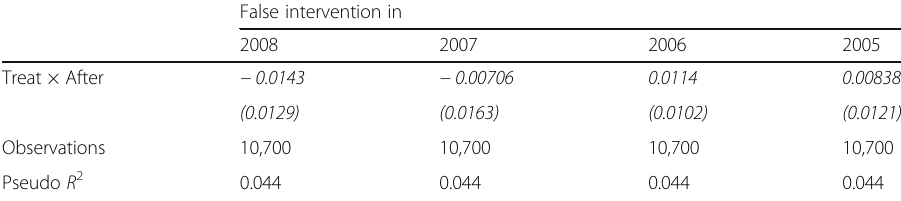
Table 4 Effect of AUH on the probability of entering the labor force. False experiments (placebo regressions) False intervention in